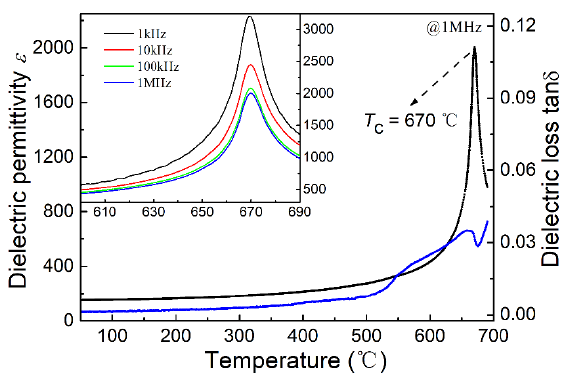
Figure 2. The relative permittivity (black curve) and dielectric loss (blue curve) of the Co-doped Na 0.5 Bi 4.5 Ti 4 O 15 (NBT-Co) ceramic measured at 1 MHz and other frequencies (embedded) as a function of temperatur e .